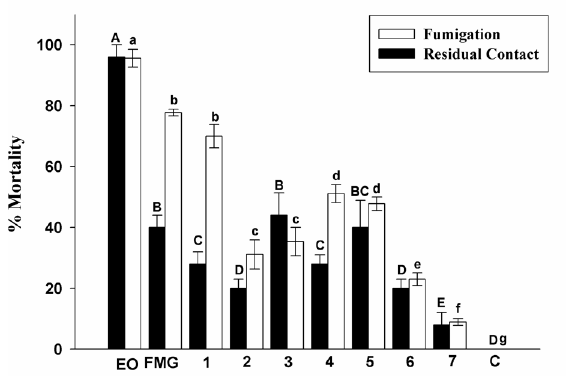
Figure 2 - Mean mortality of mite caused by incomplete blends prepared with the removal of one constituent from the complete artificial blend of the leaf oil of O. glomerata at concentration equivalent to the experiment with the leaf oil that promoted mortality ≥ 96.0% (3.6 µL L -1 air for fumigation and 22 µL mL -1 to residual contact). Bars with the same uppercase or lowercase not differ significantly by Tukey test (P ≤ 0.05). EO = essential oil from O. glomerata , FMG = Full mixture of selected constituents in the oil from O. glomerata . The numbers indicate the blends with the absence of the labeled compound. 1 = α-pinene; 2 = p- cymene; 3 = limonene; 4 = α-terpinolene; 5 = terpinen-4-ol; 6 = β-caryophyllene; 7 = aromedendrene; C = control.